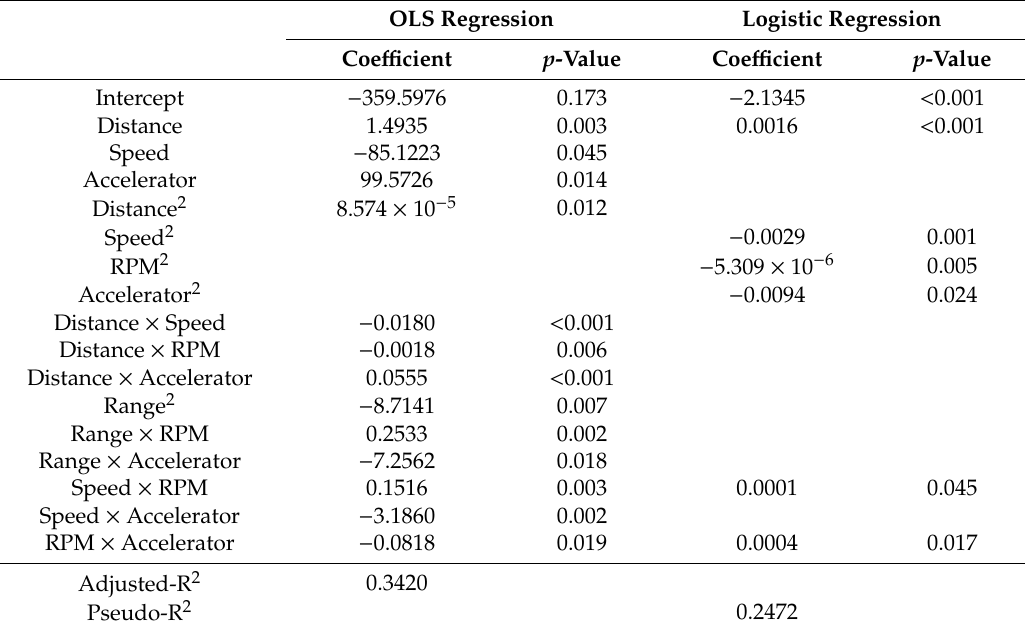
Table 3. Regression results with Brakes as a dependent variable.